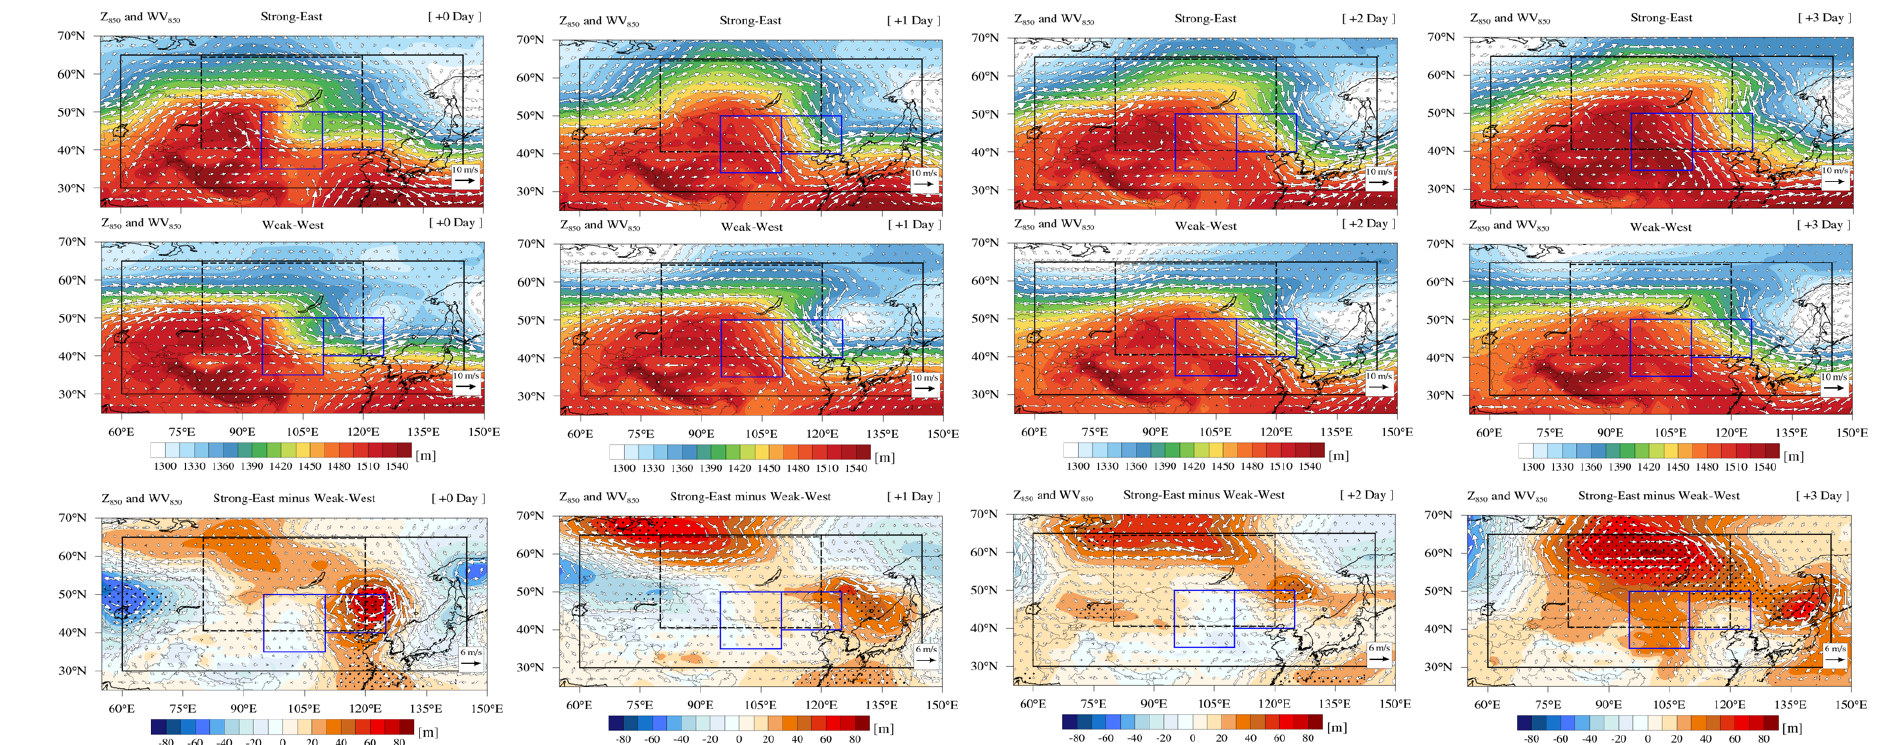
Figure 8. Same as in Figure 7 but for Z 850 (m, shaded) and WV 850 (m s − 1 ). Black dotted areas indicate where the differences are statistically significant above the 90% confidence level based on the Student’s t -test.